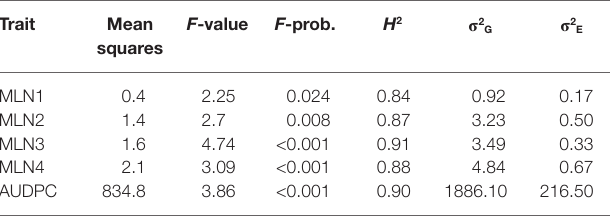
TABLE 6 | Mean squares and variance components of BC 3 F 2 populations evaluated for two seasons for resistance to MLN in Naivasha in 2018. Trait Mean F -value squares